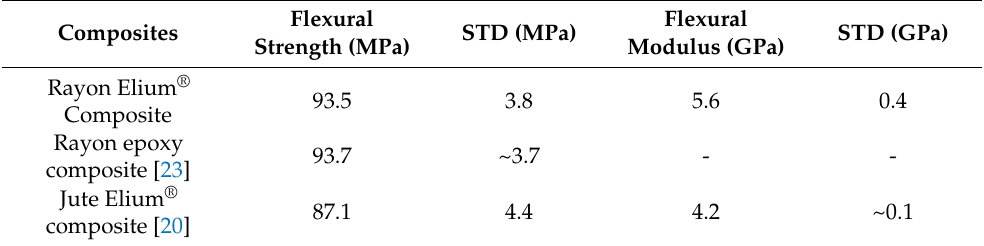
Figure 2. Stress–strain behavior of rayon composite samples. Table 4. Comparative average flexural strength and modulus of rayon fibre